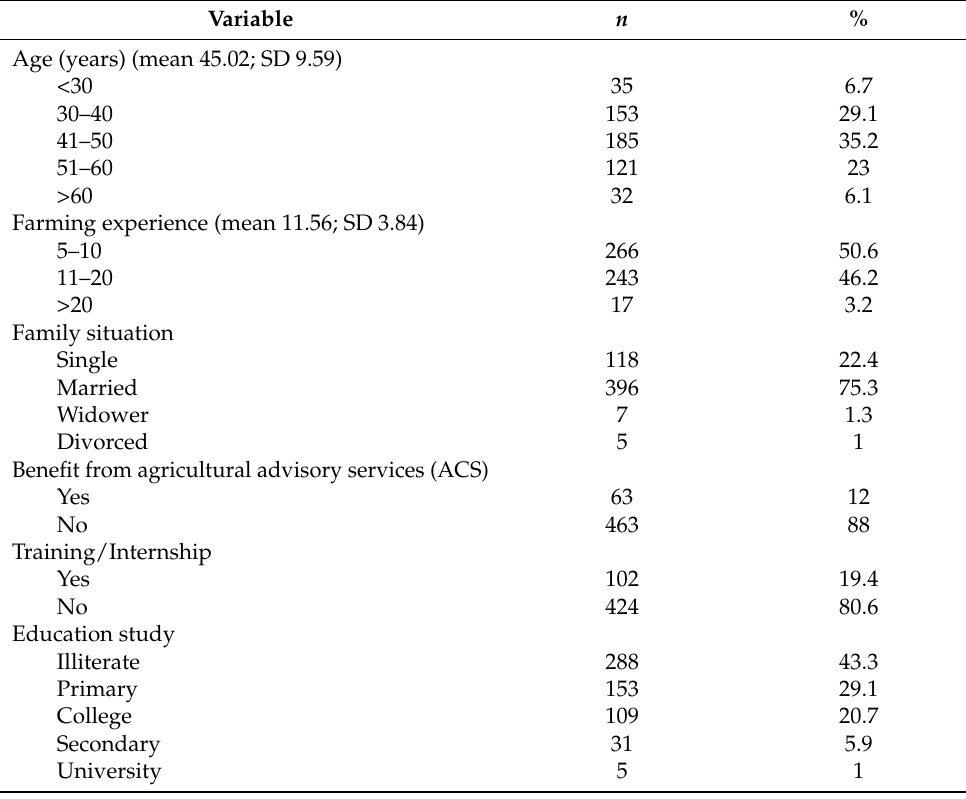
Table 2. Demographic profile of the respondents ( n =